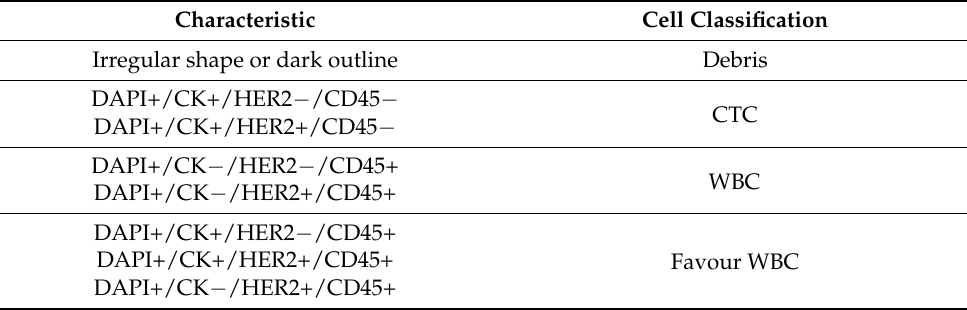
Table 5. Immunofluorescent staining characteristics for identifying